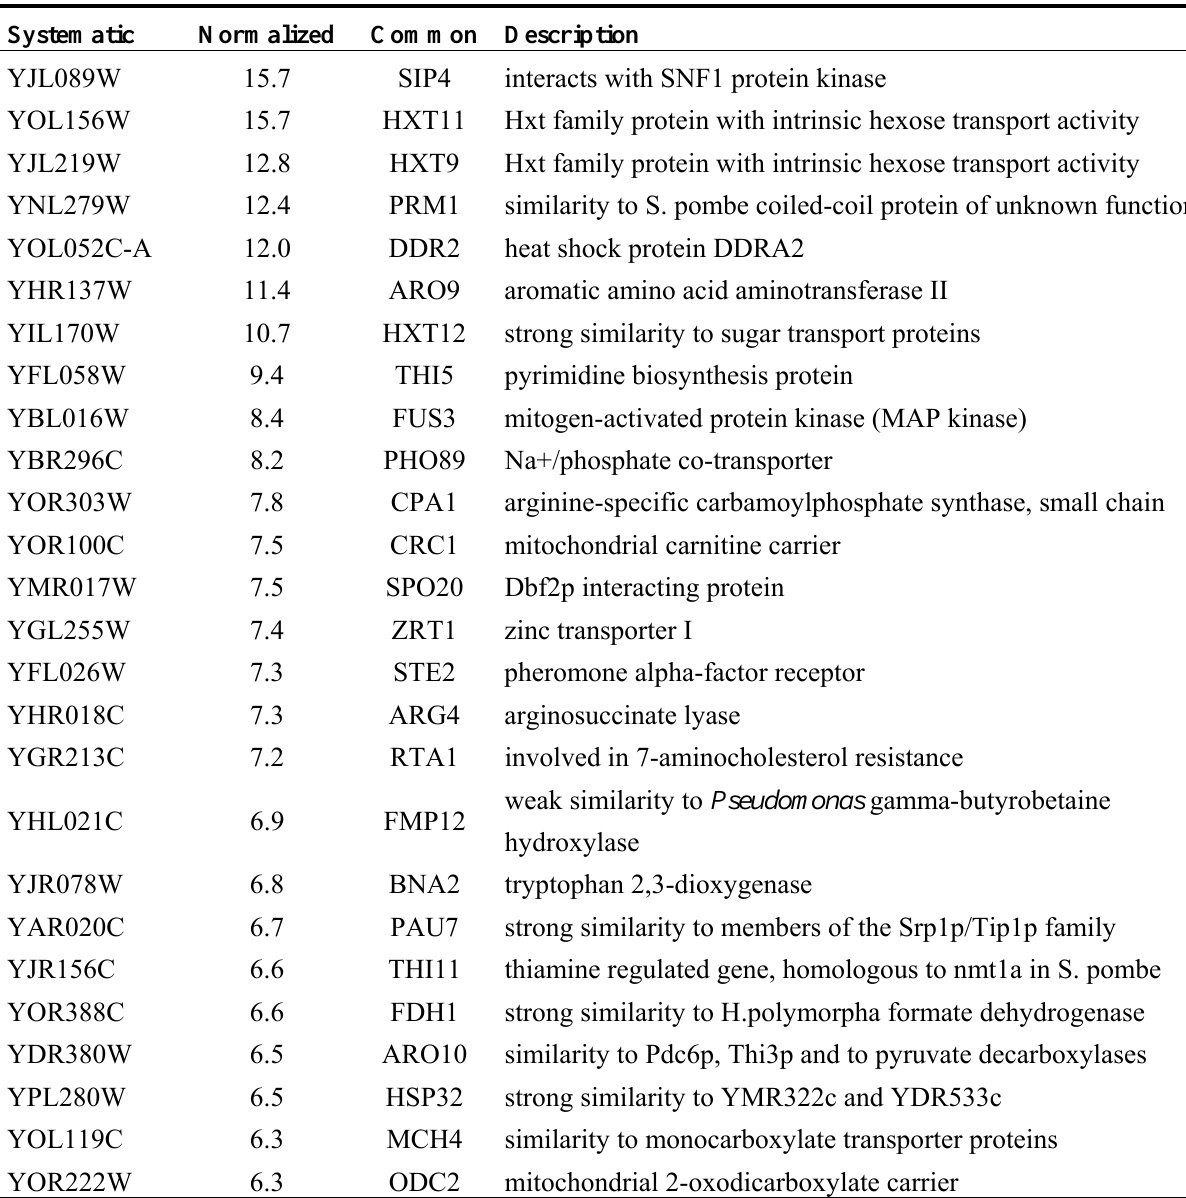
Table 1. List of highly induced genes by T-2 toxin treatment in